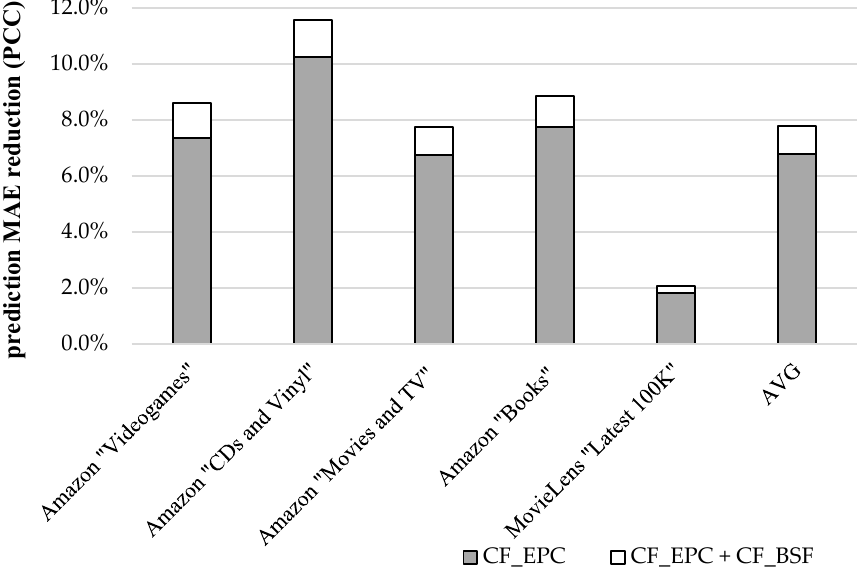
Figure 4. MAE reduction achieved by the inclusion of proposed algorithm to the CF EPC algorithm, when using the PCC user similarity metric.